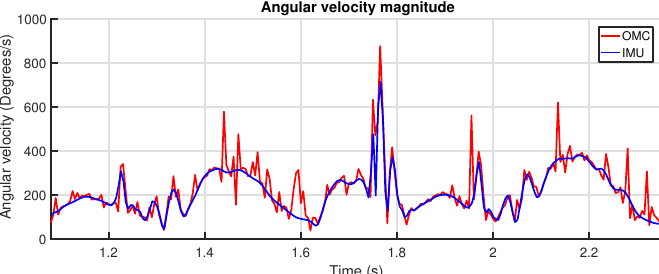
Figure 12. Example of the synchronization of angular velocity magnitude between IMU and